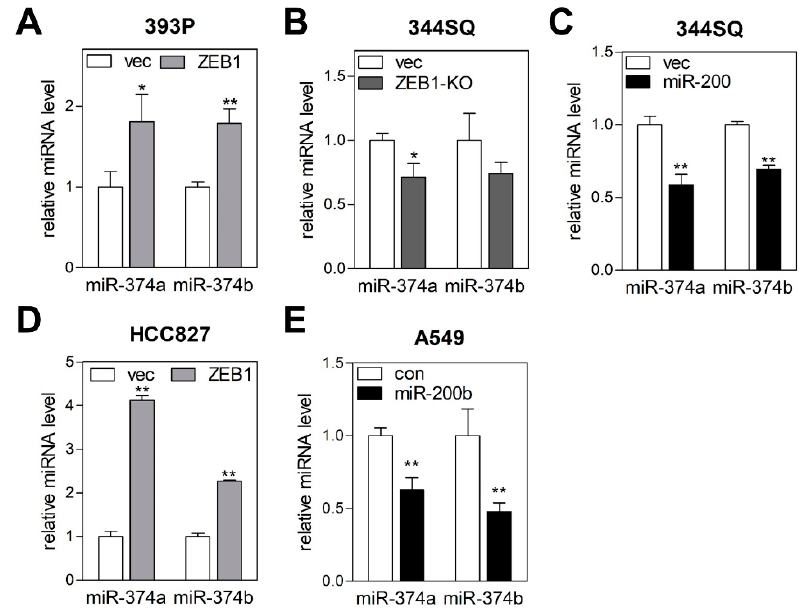
Figure 3. miR-374a and miR-374b are regulated by the ZEB1 / miR-200 feedback loop. ( A ) qRT-PCR of miR-374a and miR-374b in ZEB1 -overexpressing cells. 393P cells (epithelial-like murine lung cancer cells) were transfected with ZEB1 or empty vector (vec), and miR-374a and miR-374b expression levels were measured by qRT-PCR. Expression levels were normalized to that of the small-nucleolar RNA RNU6B . Relative values to those of 393P_vec (set to 1.0) are presented. Data represent the mean + SD ( n = 3). * p < 0.05, ** p < 0.01; two-tailed Student’s t test. ( B ) qRT-PCR of miR-374a and miR-374b in ZEB1 -knockout (KO) cells. 344SQ cells (mesenchymal-like murine lung cancer cells) expressing Cas9 nuclease were transduced with ZEB1 guide RNA ( ZEB1 -KO) or empty vector (vec), and miR-374a- and miR-374b-expression levels were measured by qRT-PCR. Data represent the mean + SD ( n = 3). * p < 0.05; two-tailed Student’s t test. ( C ) qRT-PCR of miR-374a and miR-374b in miR-200-overexpressing cells. 344SQ cells were transduced with miR-200 or empty lentiviral vector (vec), and miR-374a- and miR-374b-expression levels were measured by qRT-PCR. Data represent the mean + SD ( n = 3). ** p < 0.01; two-tailed Student’s t test. ( D ) qRT-PCR of miR-374a and miR-374b in ZEB1 -overexpressing cells. HCC827 cells were transfected with ZEB1 or empty vector (vec), and miR-374a- and miR-374b-expression levels were measured by qRT-PCR. Data represent the mean + SD ( n = 3). ** p < 0.01; two-tailed Student’s t test. ( E ) qRT-PCR of miR-374a and miR-374b in miR-200b-transfected cells. A549 cells were transfected with miR-200b or negative control mimic (con), and miR-374a- and miR-374b-expression levels were measured by qRT-PCR. Data represent the mean + SD ( n = 3). ** p < 0.01; two-tailed Student’s t test.